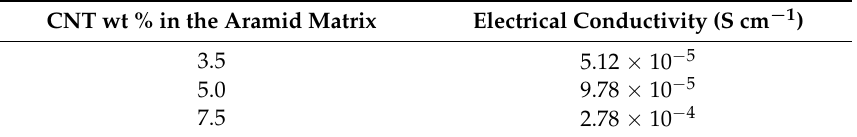
Table 2. Variation of electrical conductivity with CNT loading in Ar-CNT-P